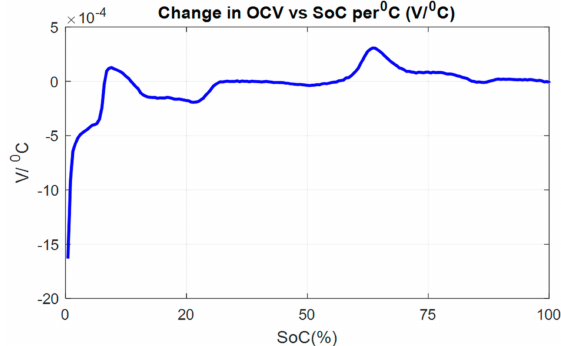
Figure 7. The change amount of OCV with respect to SoC when the temperature changes 1 ◦